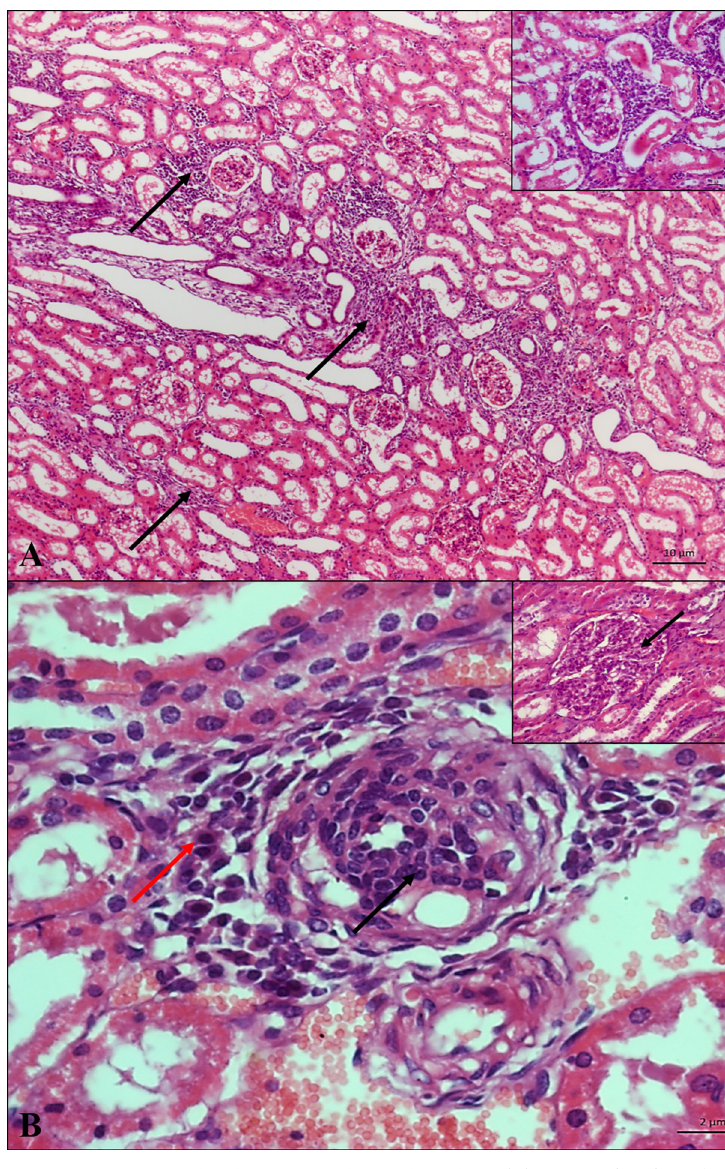
HE (magnification of 400x). ( B) Lymphoplasmocytic infiltrate (red arrow—plasmocyte, black arrow—lymphocyte). Detail: Proliferative glomerulonephritis (black arrow);